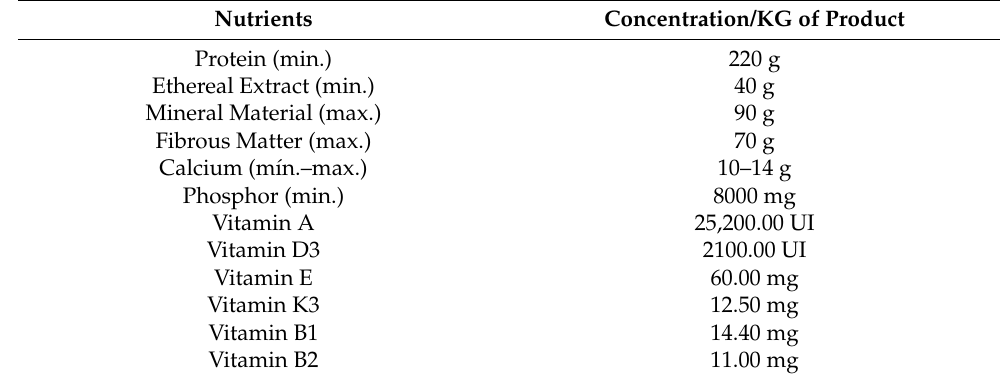
Table A1. Nutritional composition of the Nuvilab CR-1 Autoclavable animal feed (Nuvital Nutrientes S/A, Colombo, Brazil).